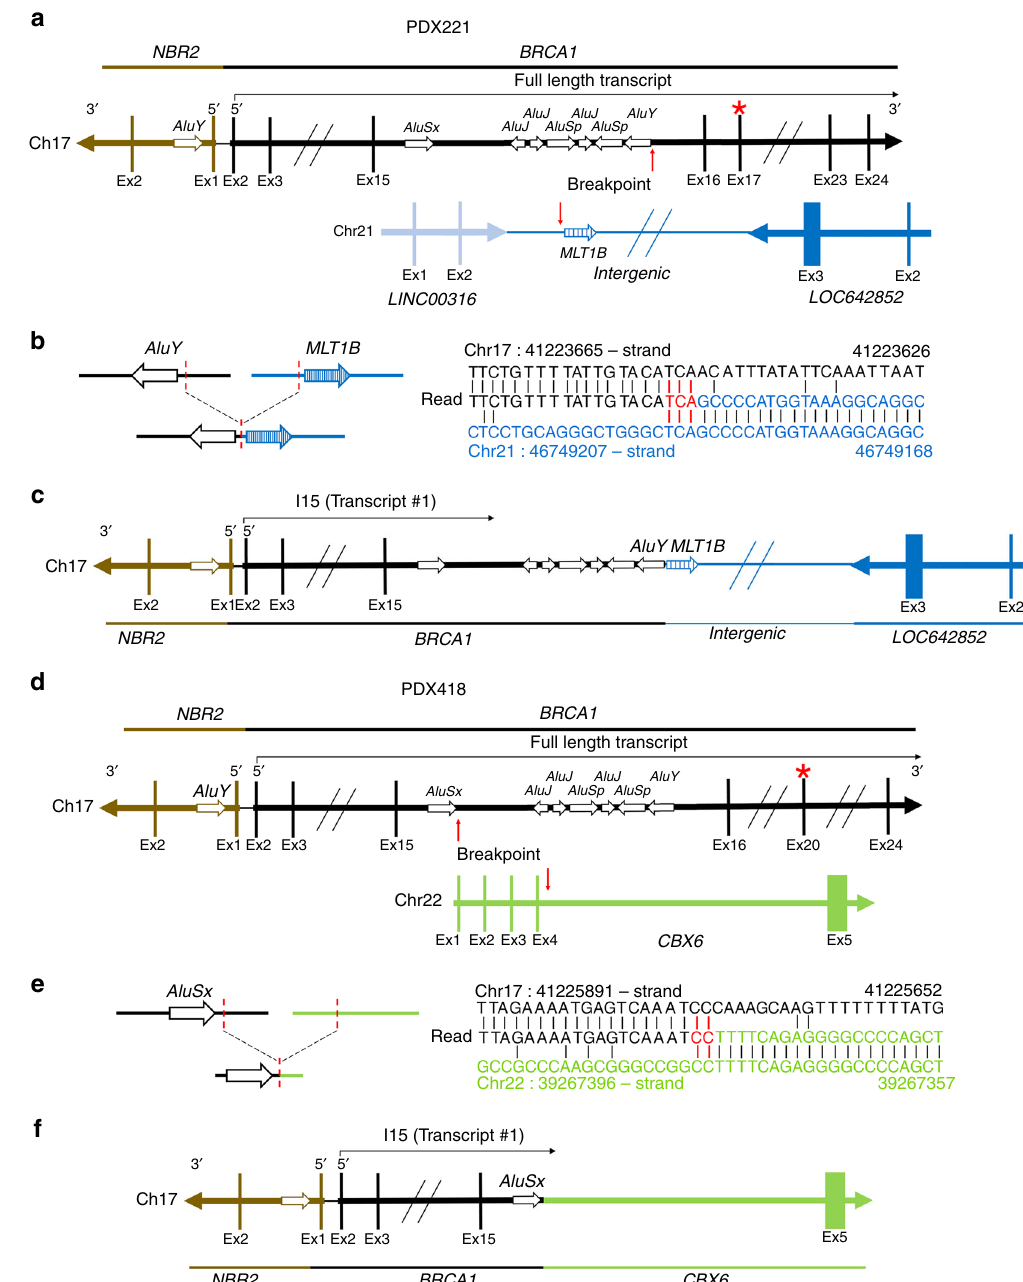
Fig. 7 BRCA1 intron 15 translocations detected in PDX tumors. a Schematic depicting the non-rearranged BRCA1 locus and chr:21q22.3 region. Chr:21q22.3 contains the long intervening/intergenic noncoding RNAs (lincRNAs) LINC00316 and LOC642852 . PDX221 has a c.5027delT mutation located in BRCA1 exon 17 that is noted with a red asterisk. Chromosome breakpoints are indicated (red arrows). b The breakpoints and junction are depicted and are within 93 bp of an AluY sequence in BRCA1 intron 15 and within 36 bp of a MLT1B sequence in chr21q22.3, dashed red line (see Supplementary Note 1). Right, reads detected by WGS that map to the indicated regions of BRCA1 intron 15 and chr21 are shown. Sequence numbers are the genomic coordinates according to the UCSC genome browser (GRCh37/hg19 assembly). Red sequence represents a region of microhomology. The read sequence colors correspond to the relative chromosome regions shown (left). c Schematic showing the chr17:21 translocation detected PDX221 that results in transcription termination in intron 15 and generates the BRCA1 intron 15 mRNA isoform. See Supplementary Fig. 5b − d and Supplementary Note 1 for more details. d Schematic depicting the non-rearranged BRCA1 locus and chr:22q23.1 region. PDX418 has a c.5266dupC mutation located in BRCA1 exon 20 that is noted with a red asterisk, and the breakpoints (red arrows) are indicated. e The breakpoints and junction are depicted and are within 117 bp of an AluSx sequence in BRCA1 intron 15; however, a SINE element was not detected in the CBX6 intron 4 sequence (see Supplementary Note 1). Right, reads detected by WGS that map to the indicated regions of BRCA1 intron 15 and CBX6 intron 4 are shown. Sequence numbers are the genomic coordinates according to the UCSC genome browser (GRCh37/hg19 assembly). Red sequence represents a region of microhomology. The read sequence colors correspond to the relative chromosome regions shown (left). f Schematic showing the chr17:22 translocation detected PDX418 that results in transcription termination in intron 15 and generates the BRCA1 intron 15 mRNA isoform. See Supplementary Fig. 5b − d and Supplementary Note 1 for more